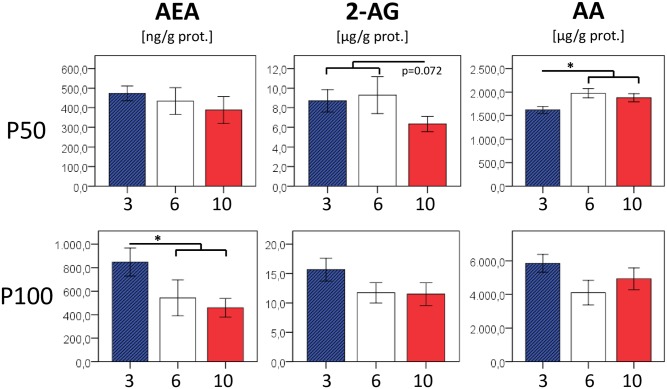
Concentrations of endocannabinoids anandamide (AEA) and 2-arachidonoyl glycerol (2 AG) as well as arachidonic acid (AA) in liver tissue.In addition to higher AEA (P100, p = 0.049) in formerly overfed animals and a trend towards lower 2-AG concentrations in formerly underfed animals (P50, p = 0.072), we observed a significantly reduced total amount of the eCB component arachidonic acid (AA) in the former overfed group (3 vs. 6/10 p = 0.023). n = 4–7 males per nutrition group.